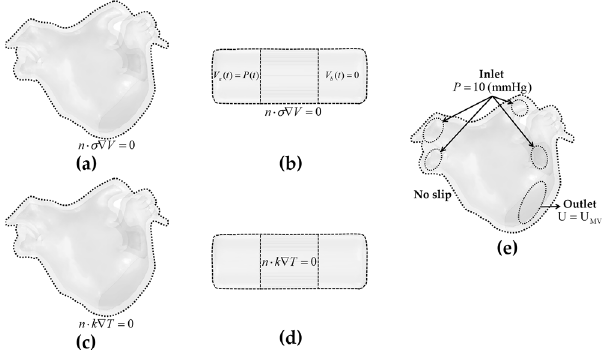
Figure 5. The electrical boundary conditions, thermal boundary conditions, and CFD boundary conditions of the ablation model. Electrical boundary conditions of ( a ) the LA model and ( b ) the catheter model; thermal boundary conditions of ( c ) the LA model and ( d ) the catheter model; and CFD boundary conditions of ( e ) the LA model.